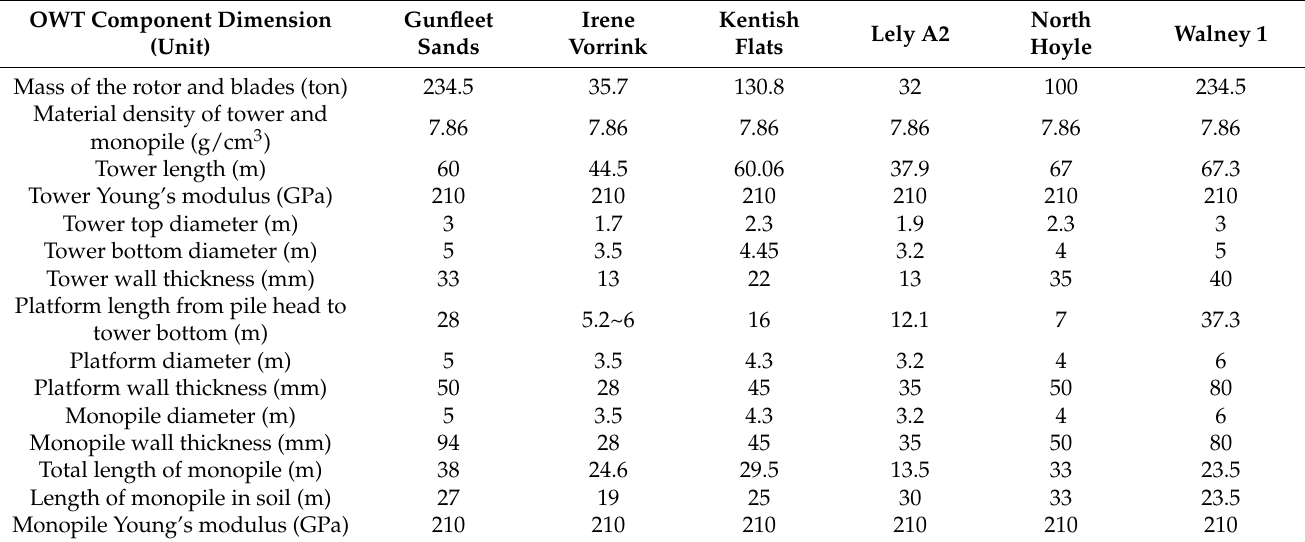
Table 1. Input parameters for predicting the natural frequency of six